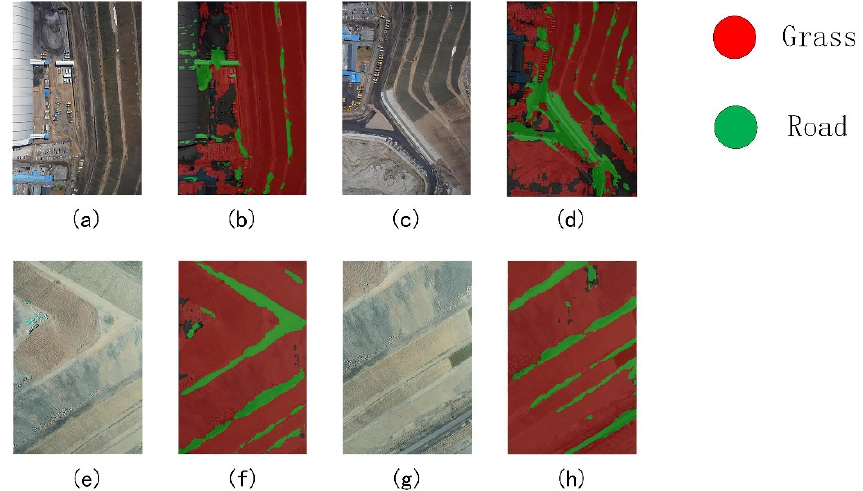
Figure 15. Application of the method proposed in the paper on other mining sites, where ( a – d ) are the original and result maps of the Munshi drainage field, and ( e – h ) are the original and result maps of the Mengtai drainage field.